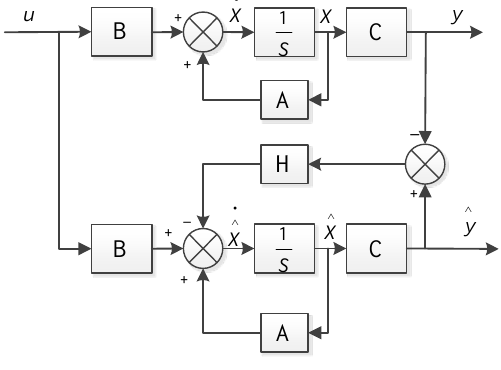
Figure 4. Block diagram of the state